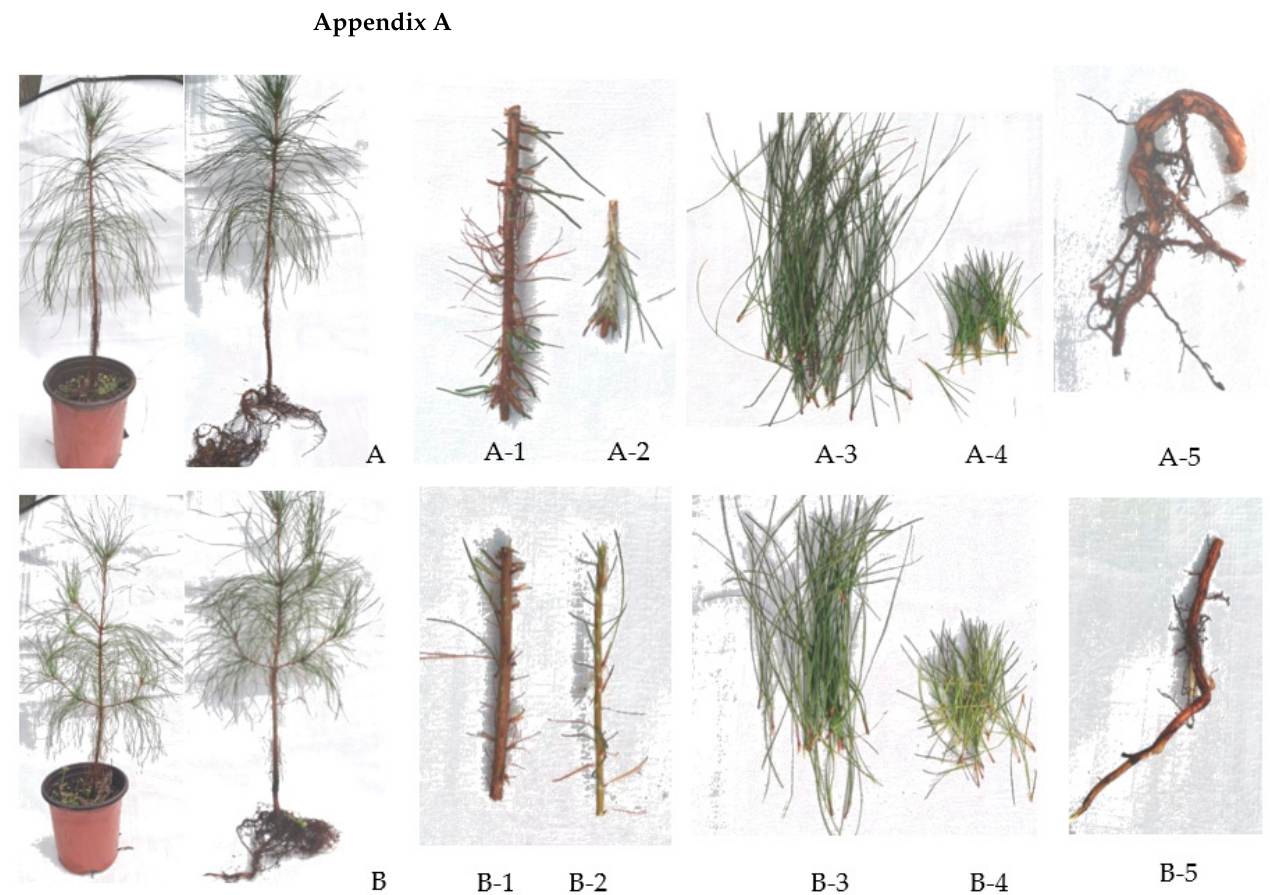
Figure A1. The pictures of slash pine and loblolly pine. ( A ) stands for slash pine, ( A1 – A5 ) represent mature and young stems, mature and young needles, and roots; ( B ) stands for loblolly pine, ( B1 – B5 ) represent mature and young stems, mature and young needles, and roots.